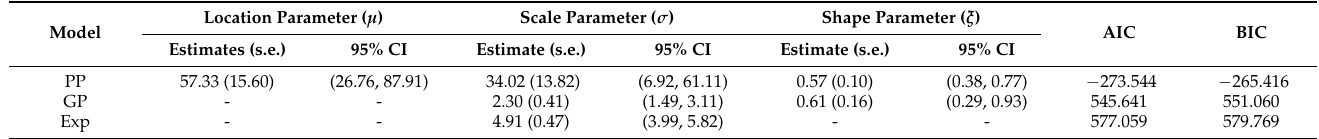
Table 2. AIC, BIC, and estimates of the location, scale, and shape parameters with standard errors (s.e.) in parentheses when fitting economic excess losses by point -process (PP), generalized Pareto (GP), and exponential (Exp.) models. Here, the threshold u = 1.879.